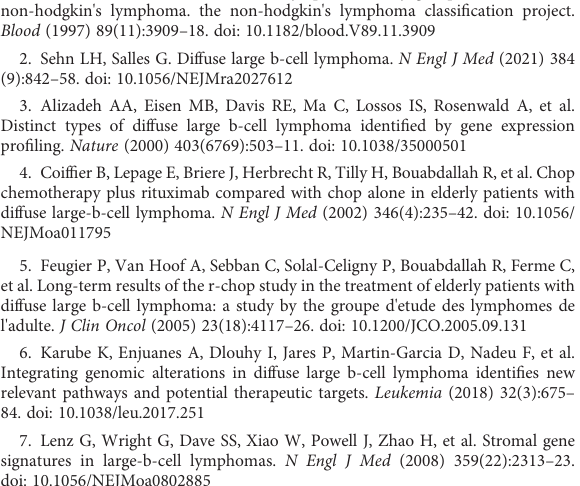
SUPPLEMENTARY FIGURE 1 (A) CorrelationanalysisofCNVandsurvivalinDLBCL. (B) Therelationships between expression of CRGs and survival in DLBCL. (C) Correlation analysis of gene methylation of CRGs and survival in DLBCL. The bubble color from blue to red represents the hazard ratio from low to high, and bubble size is positively correlated with the Cox P value signi fi cance. The black outline border indicates Cox P value ≤ 0.05. SUPPLEMENTARY FIGURE 2 Validation of CRG clusters. (A, C) The consensus matrix of the consensus clustering. (B, D) The sample clustering consistency diagram. A and B were for GSE31312. C and D were for TCGA-DLBCL. Two clusters (k=2) would be best. SUPPLEMENTARY FIGURE 3 Prediction of drug responsiveness in the distinct subtypes. IC50, half maximal inhibitory concentration. SUPPLEMENTARY FIGURE 4 Validation of the prognostic signature in GSE87371. (A) Kaplan-Meier curve in the high- and low-risk group. (B) Sensitivity and speci fi city of the risk score model assessed by time-depend ROC analysis. (C) Ranked dot and scatter plots showing the risk score distribution and patients ’ survival status. SUPPLEMENTARY FIGURE 5 (A) Differences in risk scores among groups with distinct